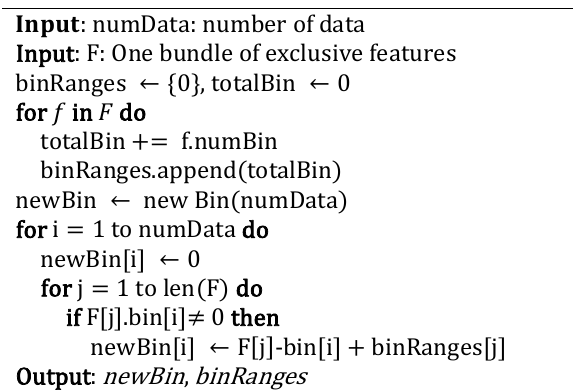
Algorithm 2. Merge Exclusive Features